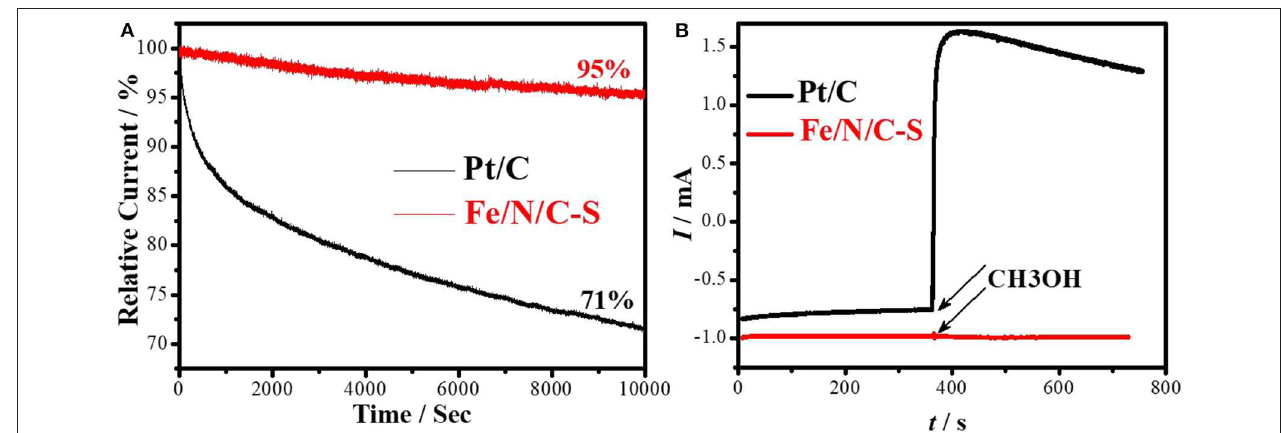
FIGURE 8 | (A) Stability test of Fe/N/C-S and Pt/C catalysts at constant potential 0.8V for 10,000s. (B) Methanol tolerance (0.5M conce.), in O 2 -saturated 0.1M NaOH with Scan rate: 10mV s − 1 ; Rotating rate: 900 rpm.